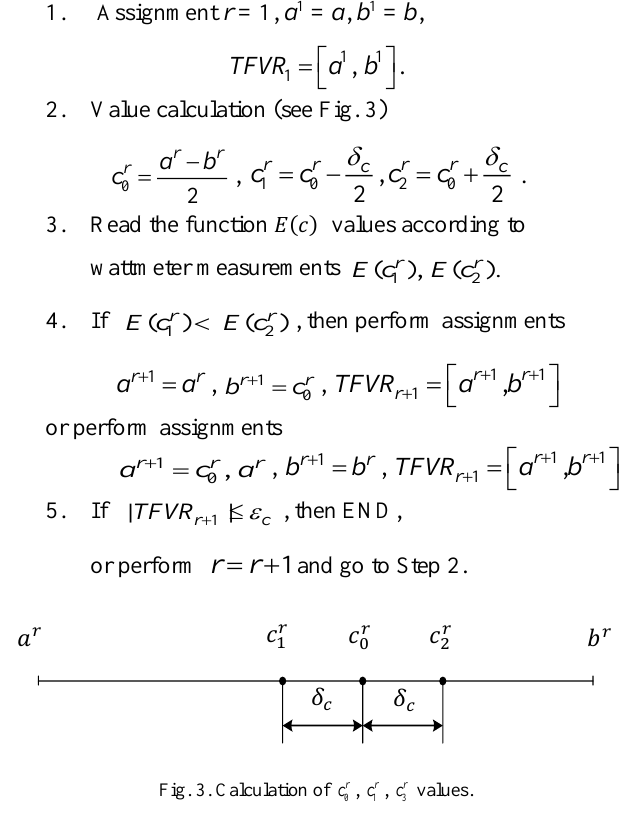
Fig. 3. Calculation of